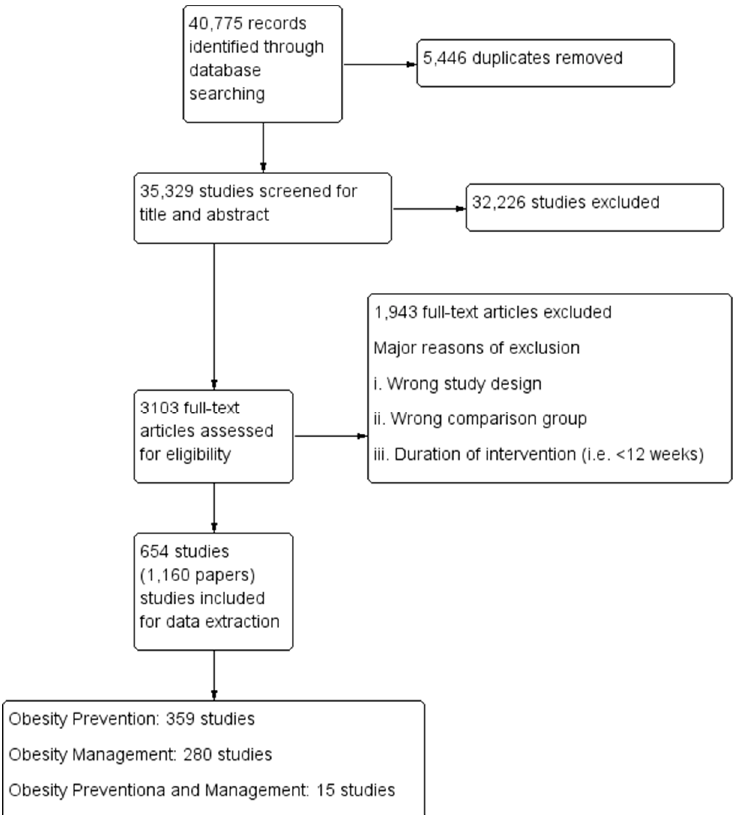
Figure 1. Study flow diagram.